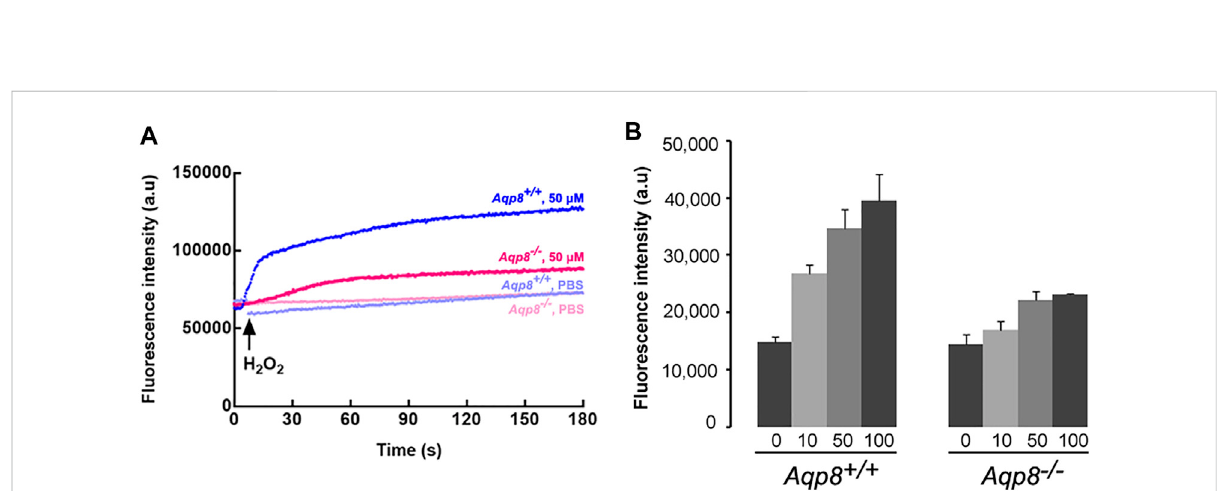
FIGURE 3 H 2 O 2 uptake into primarily cultured granulosa cells. (A) Representative fl uorescence intensity of CM-H2DCFDA. (B) Granulosa cells were incubated with H 2 O 2 (0 – 100 mM), and cellular H 2 O 2 was detected by CM-H2DCFDA fl uorescence using a plate reader. Increased fl uorescence intensity could be detected at 15 s after treatment with H 2 O 2 . Data were shown as mean ±